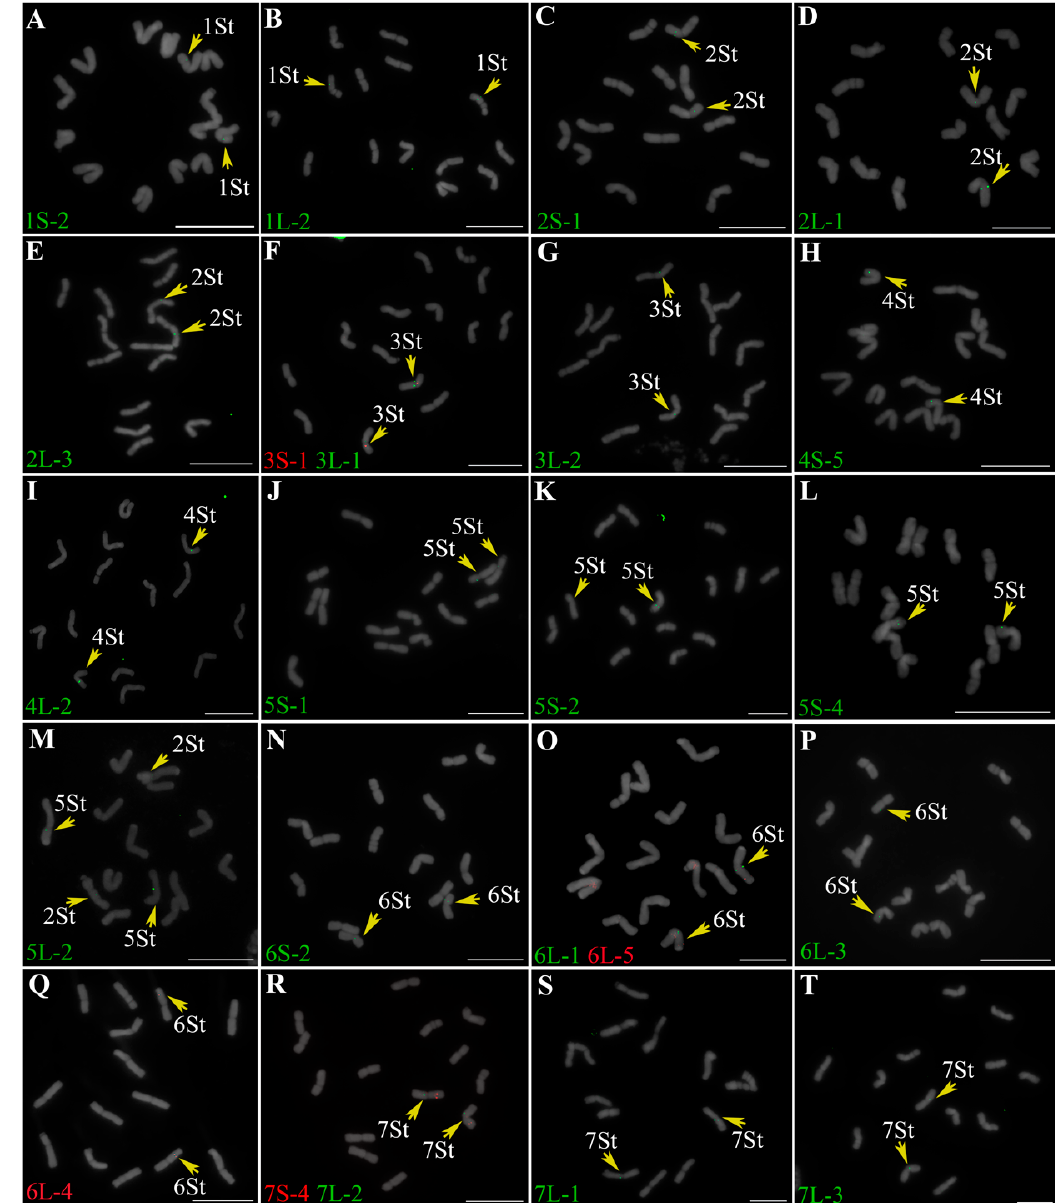
Figure 1. Common wheat single-copy gene FISH probes to distinguish seven homoeologous chromo- some groups of P. libanotica . ( A , B ) 1S-2 and 1L-2 in green were identified the 1St chromosome pair. ( C – E ) 2S-1, 2L-1, and 2L-3 in green were displayed signals on the 2St chromosome pairs. ( F , G ) 3S-1 in red, 3L-1 and 3L-2 in green were presented on the 3St chromosome pair. ( H , I ) 4S-5 and 4L-2 in green were visualized on the 4St chromosomes. ( J – M ) 5S-1, 5S-2, 5S-4 in green were localized on the short arm of 5St, 5L-2 was hybridized with 2St and 5St chromosomes. ( N – Q ) 6S-2, 6L-1, and 6L-3 in green, 6L-4 and 6L-5 in red were distributed on the 6St chromosomes. ( R – T ) 7S-4 in red, 7L-1, 7L-2, and 7L-3 in green were observed on the 7St chromosomes. Probes were labeled green and red fluorescein. The homoeologous chromosome group was marked with yellow arrows. Scale bar equals 10 µ